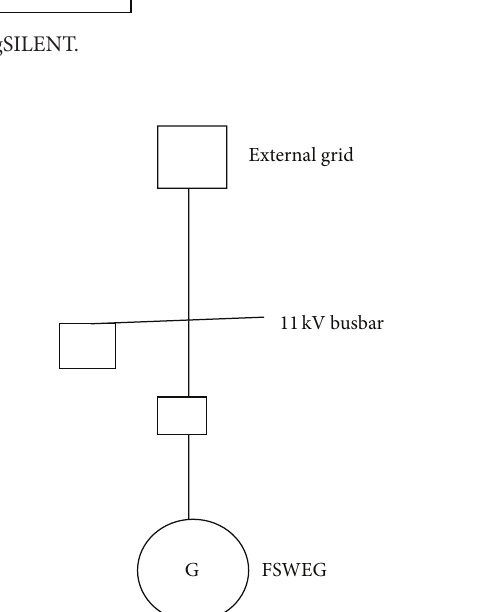
Figure 7: Representation of FSWEG in